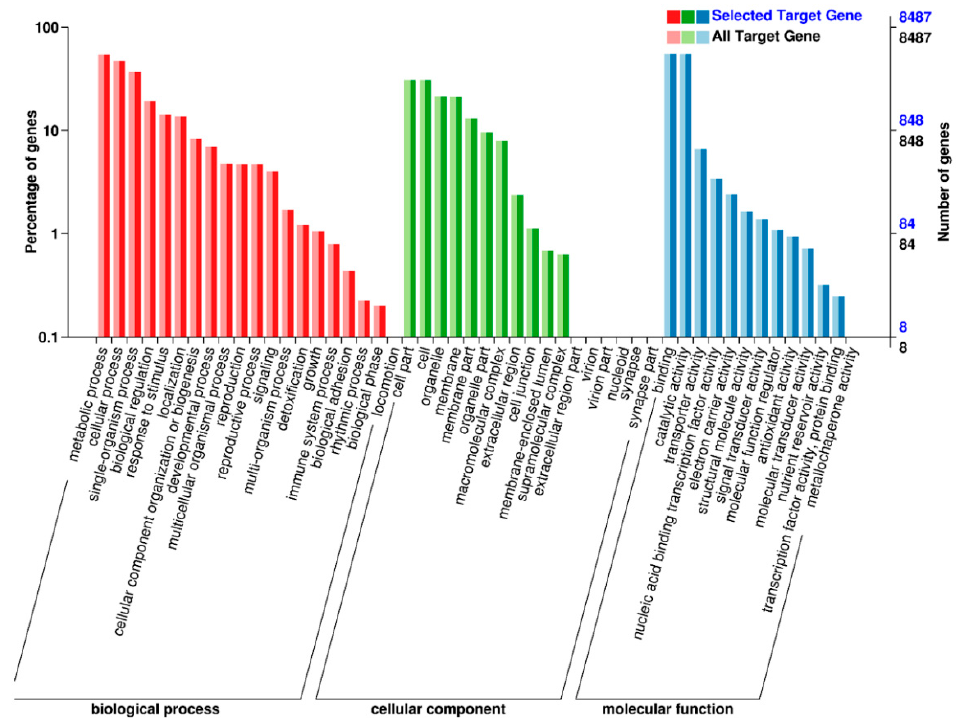
Figure 7. GO function classification of target genes of differentially expressed miRNAs. The left Y axis stands for the percentage of target genes, and the right Y axis stands for the number of target genes and the X axis stands for the function classification in biological process, cellular components, and molecular function.